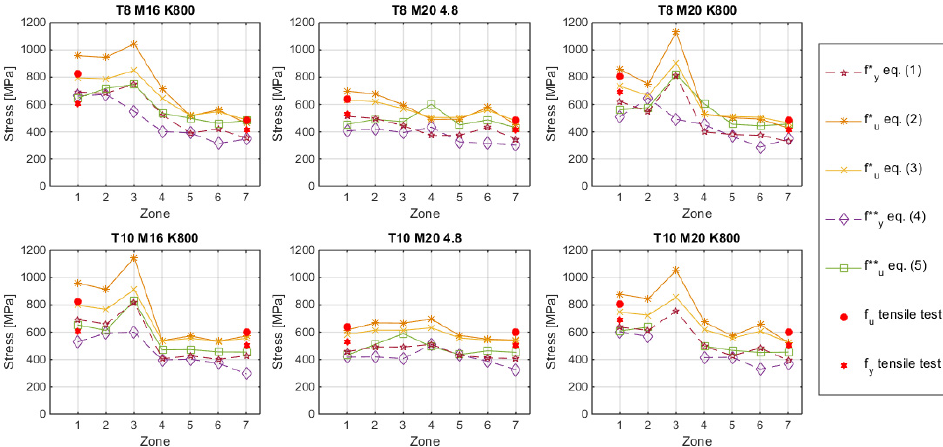
Figure 12. Yield stress and ultimate tensile strength profiles along different zones of the specimens.